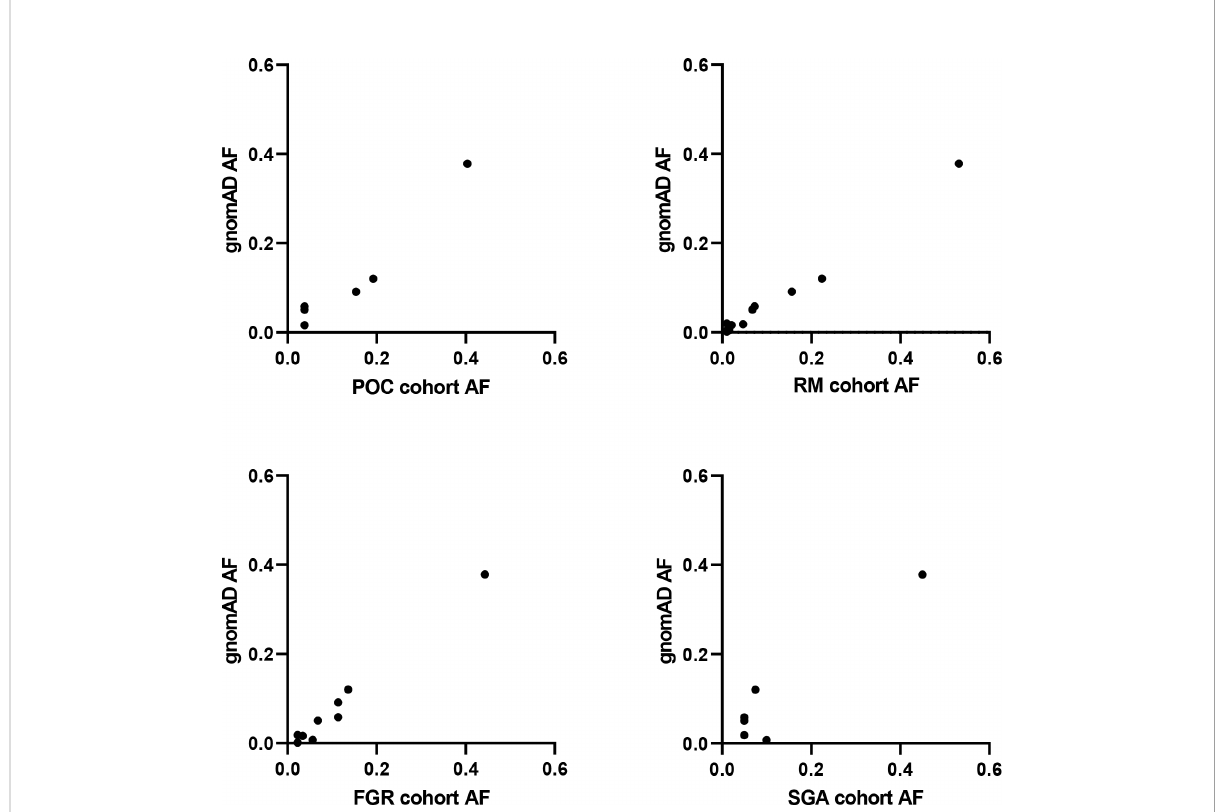
FIGURE 6 SAMD9 variants in studied cohorts. Correlation plots between allele frequency (AF) of SAMD9 variants detected in our cohorts and that present in gnomAD. No data are shown for Silver-Russell Syndrome (SRS) as no variants in SAMD9 were detected. POC, Product of Conception; RM, Recurrent Miscarriage; FGR, Fetal Growth Restriction; SGA, Small for Gestational